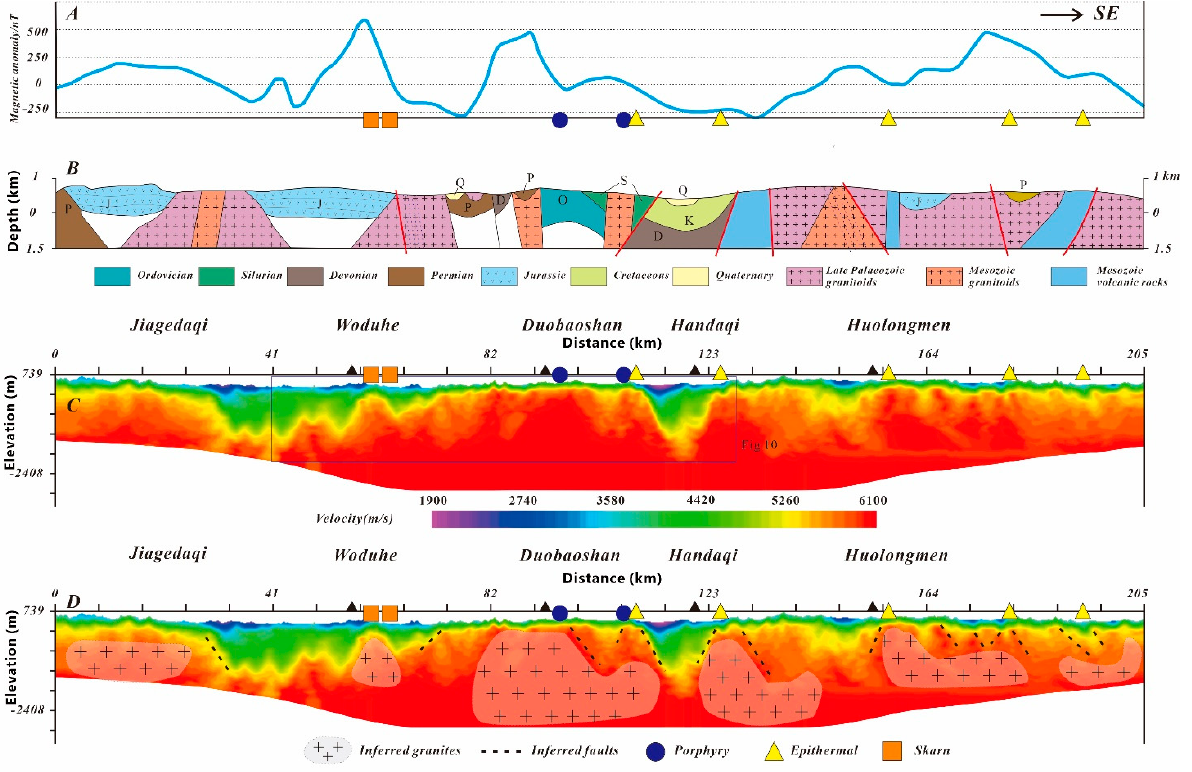
Figure 9. Tomographic inversion results and interpretation. ( A ) Magnetic anomalies along deep seismic profile. ( B ) Geological profile. ( C ) Velocity profile of first-arrival seismic tomography inversion. ( D ) Interpretation of velocity structure.